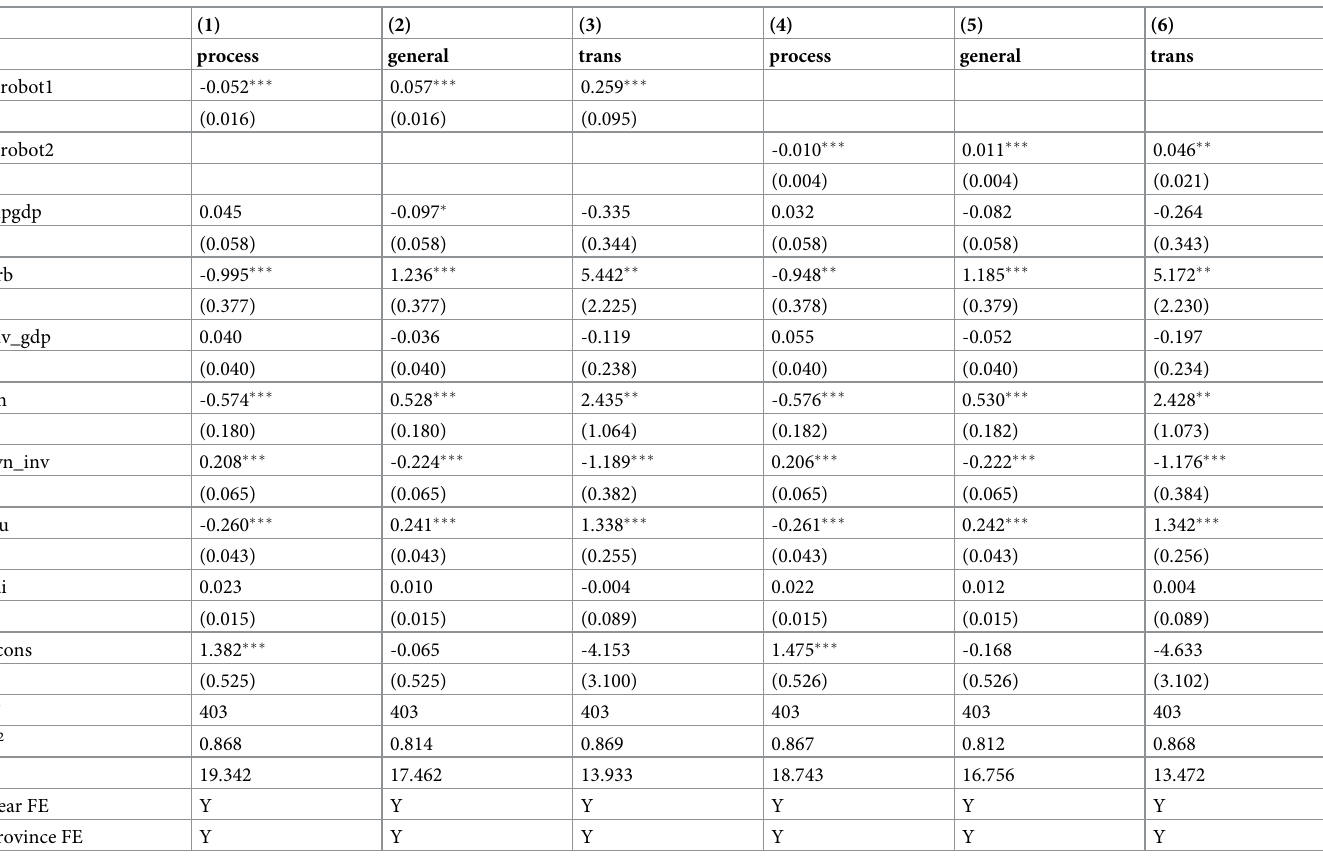
Table 4. Results of lag one phases